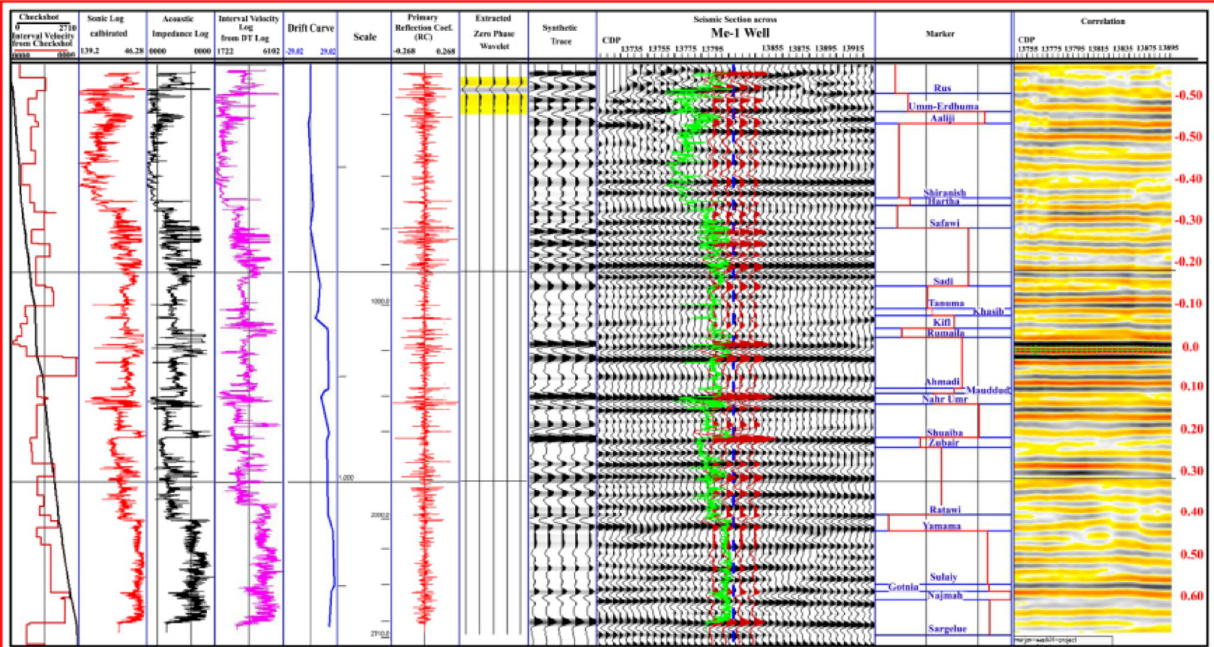
Fig. 4 Synthetics seismogram of Me-1 shows a good tie with seismic